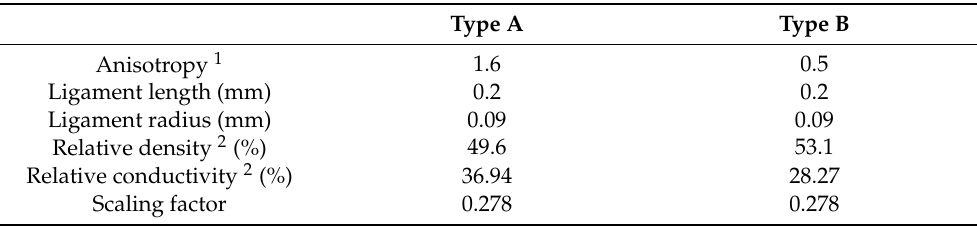
Table 1. Geometric characteristics and equivalent physical properties of the two optimised cell